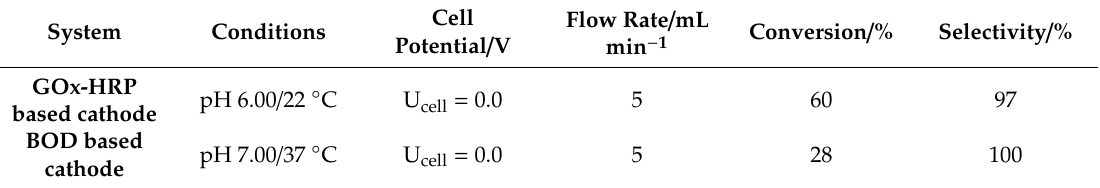
Figure 8. Comparison of glucose conversion in two different reactors.